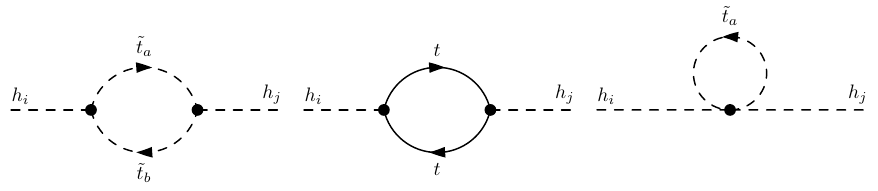
Figure 1 . Generic one-loop self-energies of the neutral Higgs bosons h i;j ( i; j = 1 ; : : : ; 5) at O ( (cid:11) t ). A summation over all internal particles with indices a; b = 1 ; 2 is